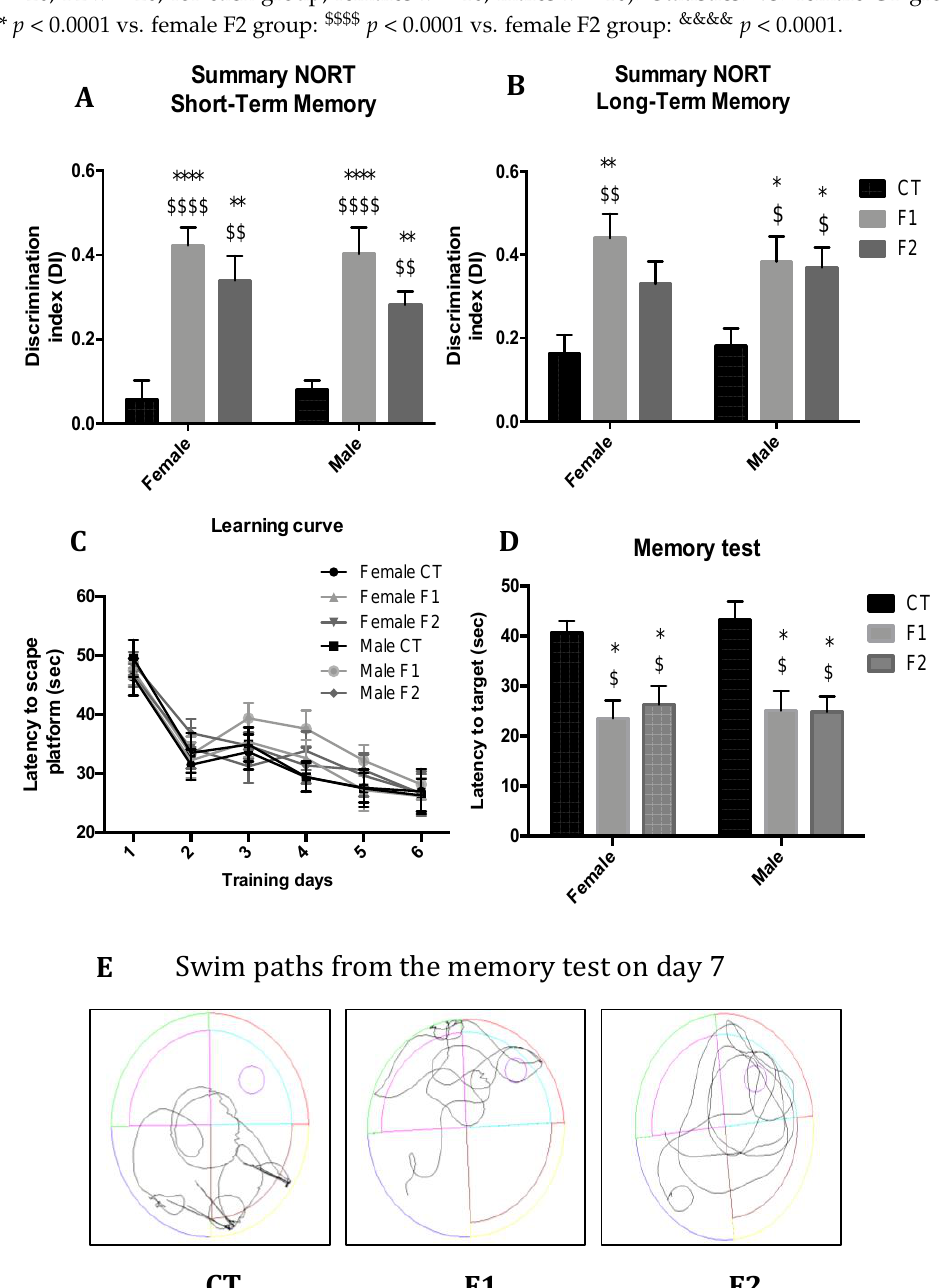
Figure 2. Results of DI of Novel Object Recognition Test (NORT) in females and males at 6 months of